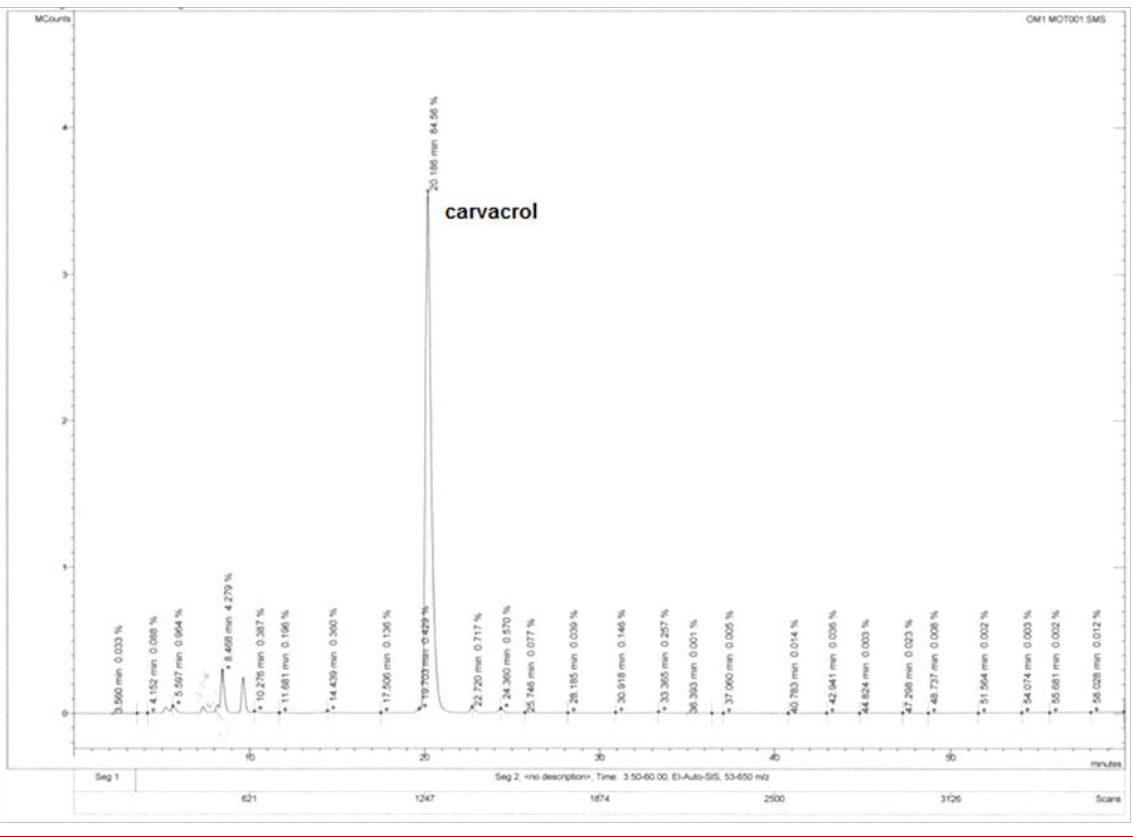
Figure 1: Chromatogram of the essential oil extracted from air-dried leaves of O.